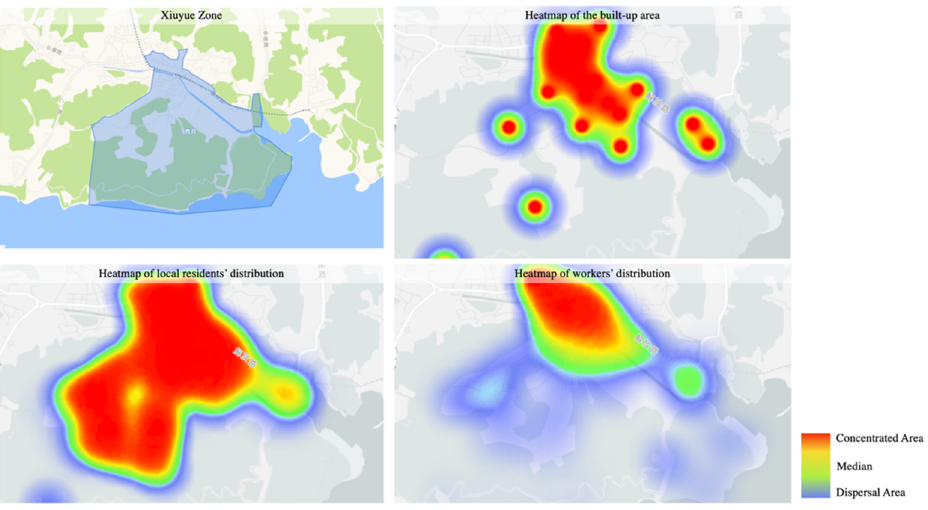
Figure 5. Heatmaps of Xiuyue Zone. Source: Authors.